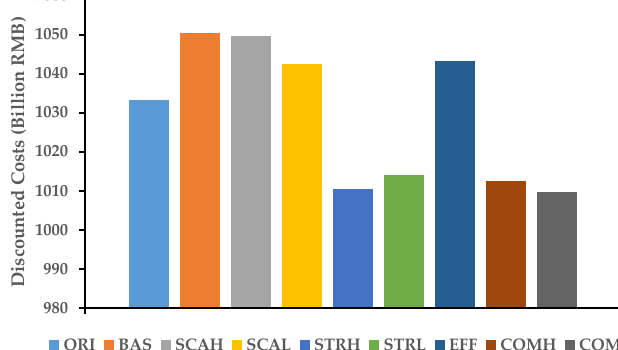
Figure 8. Total discounted costs under different scenarios.